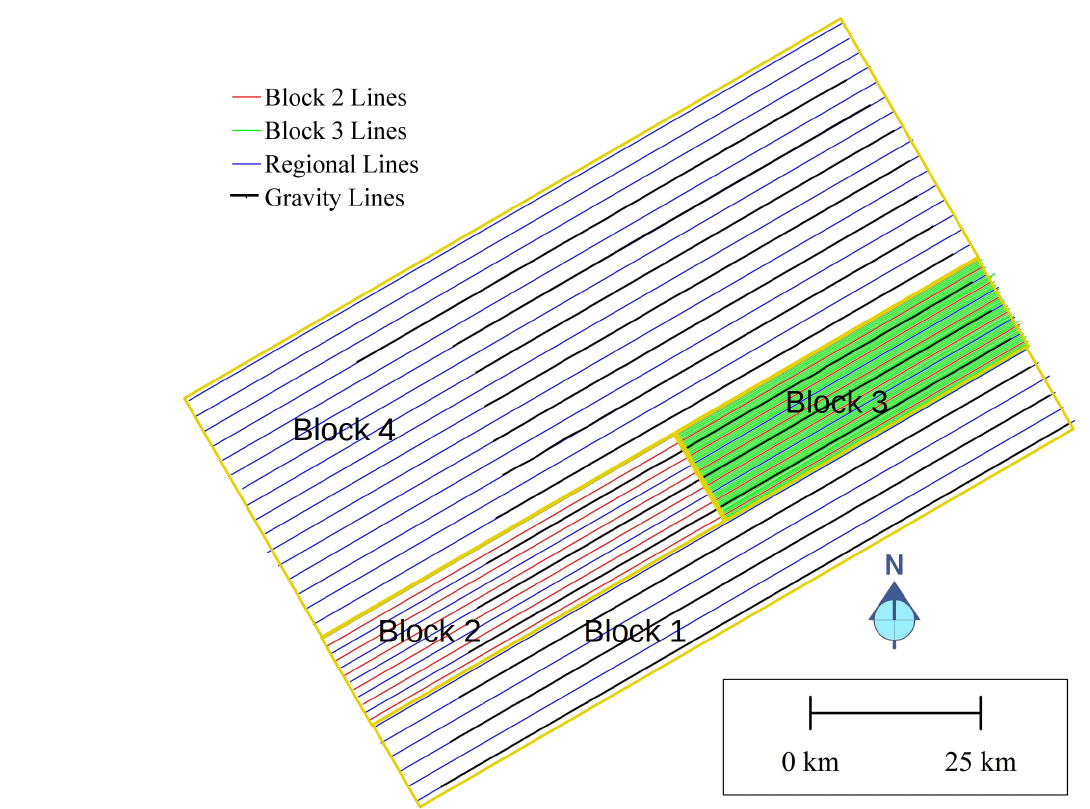
Figure 1. Layout of the survey design with four blocks outlined in yellow. The actual flight lines for each block plus the gravity flight lines are also